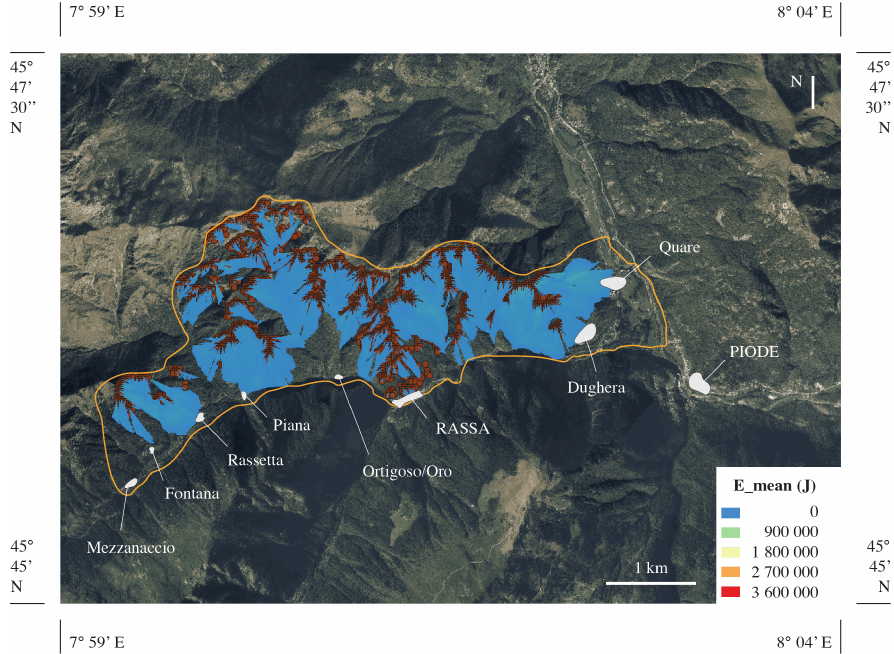
Figure 5. Mean energy map for the forecasting analysis of the 0.1 m 3 rockfall